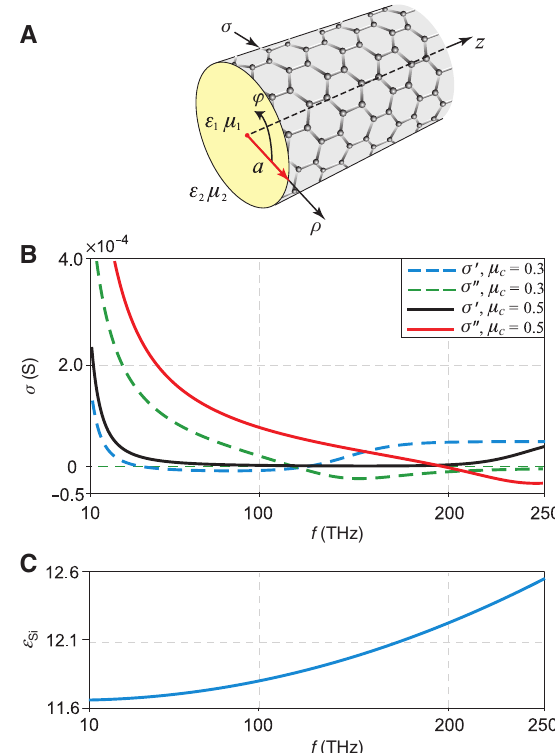
Figure 1: Geometry and material description of a nanowire. (A) Schematic of a graphene-coated semiconductor nanowire and dispersion characteristics of (B) graphene conductivity σ for differ- ent values of the chemical potential μ at fixed temperature T = 300